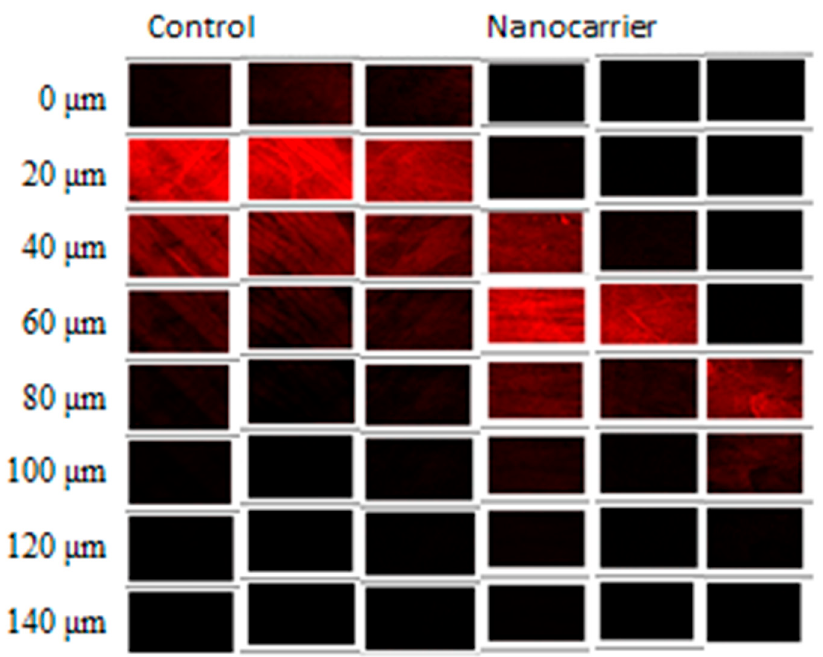
Figure 3. CLSM images of the drug–loaded nanocarrier formulation and control group fluorolabelled with rhodamine B. (sectioned from 0 to 140 μ m with 20 μ m increments) n = 3.